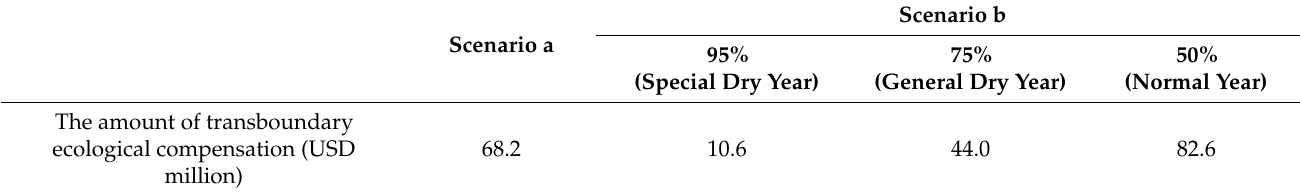
Table 8. The amount of ecological compensation of water quality and quantity in two